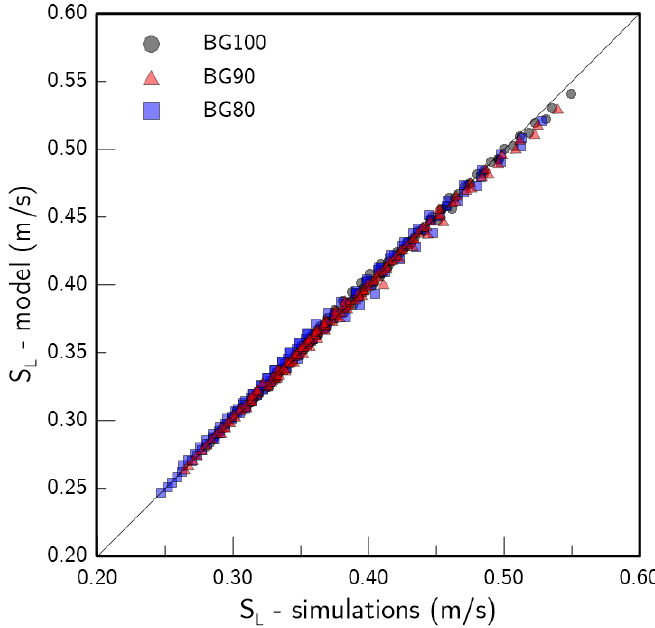
Figure 10. Model predictions vs. the numerical results of laminar flame speed S L . Symbols indicate base biogas compositions. All equivalence ratio and H are